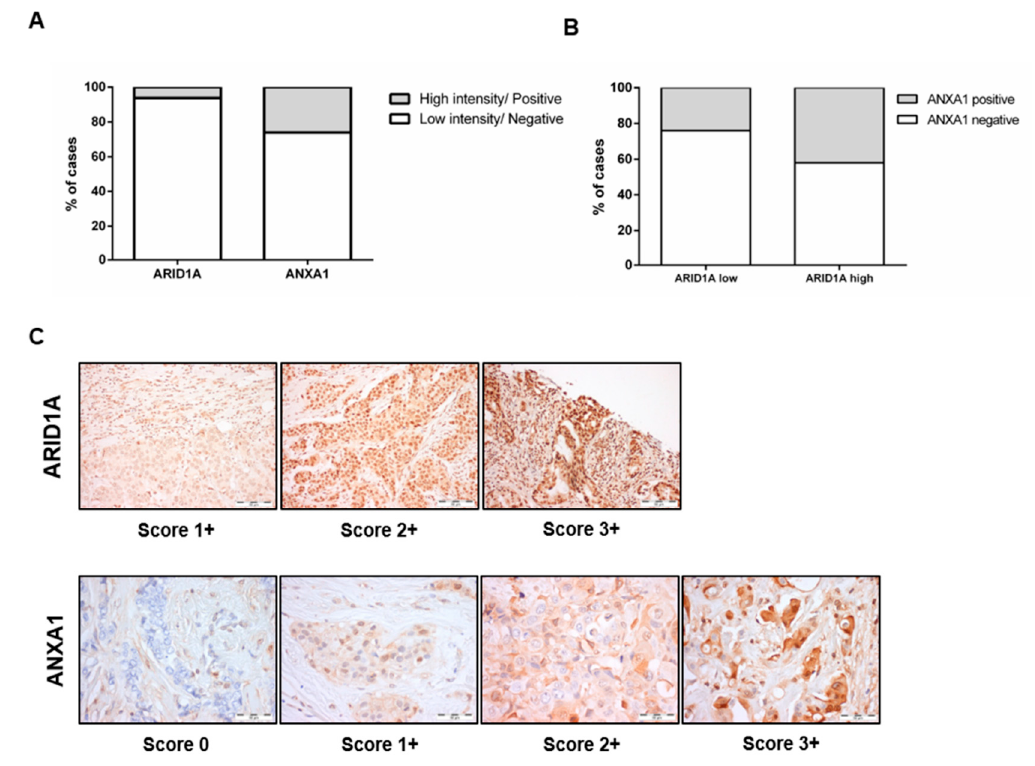
Figure 2. Relationship between ARID1A and ANXA1. Proportion of tumours with ARID1A high or low intensity and ANXA1 negativity or positivity ( A ). Association between ARID1A and ANXA1 (Chi-square: p = 0.183) ( B ). Illustrative images of the different protein intensity scores ( C ).